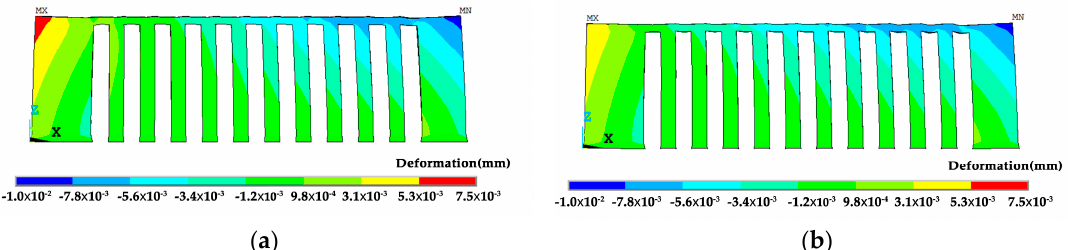
Figure 12. Shrinkage in the x direction of the specimens under different scanning strategies cooled to room temperature (deformation magnification 5×): ( a ) the x scanning route; and, ( b ) the y scanning route.